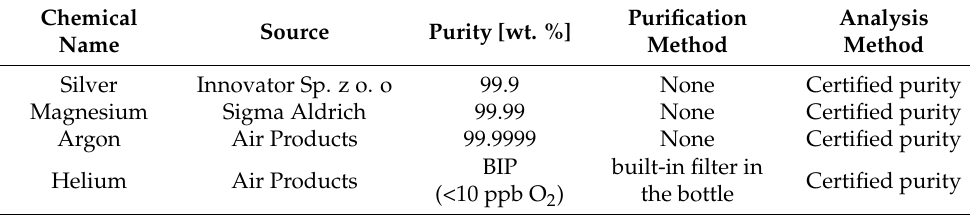
Table 1. Specification of the applied